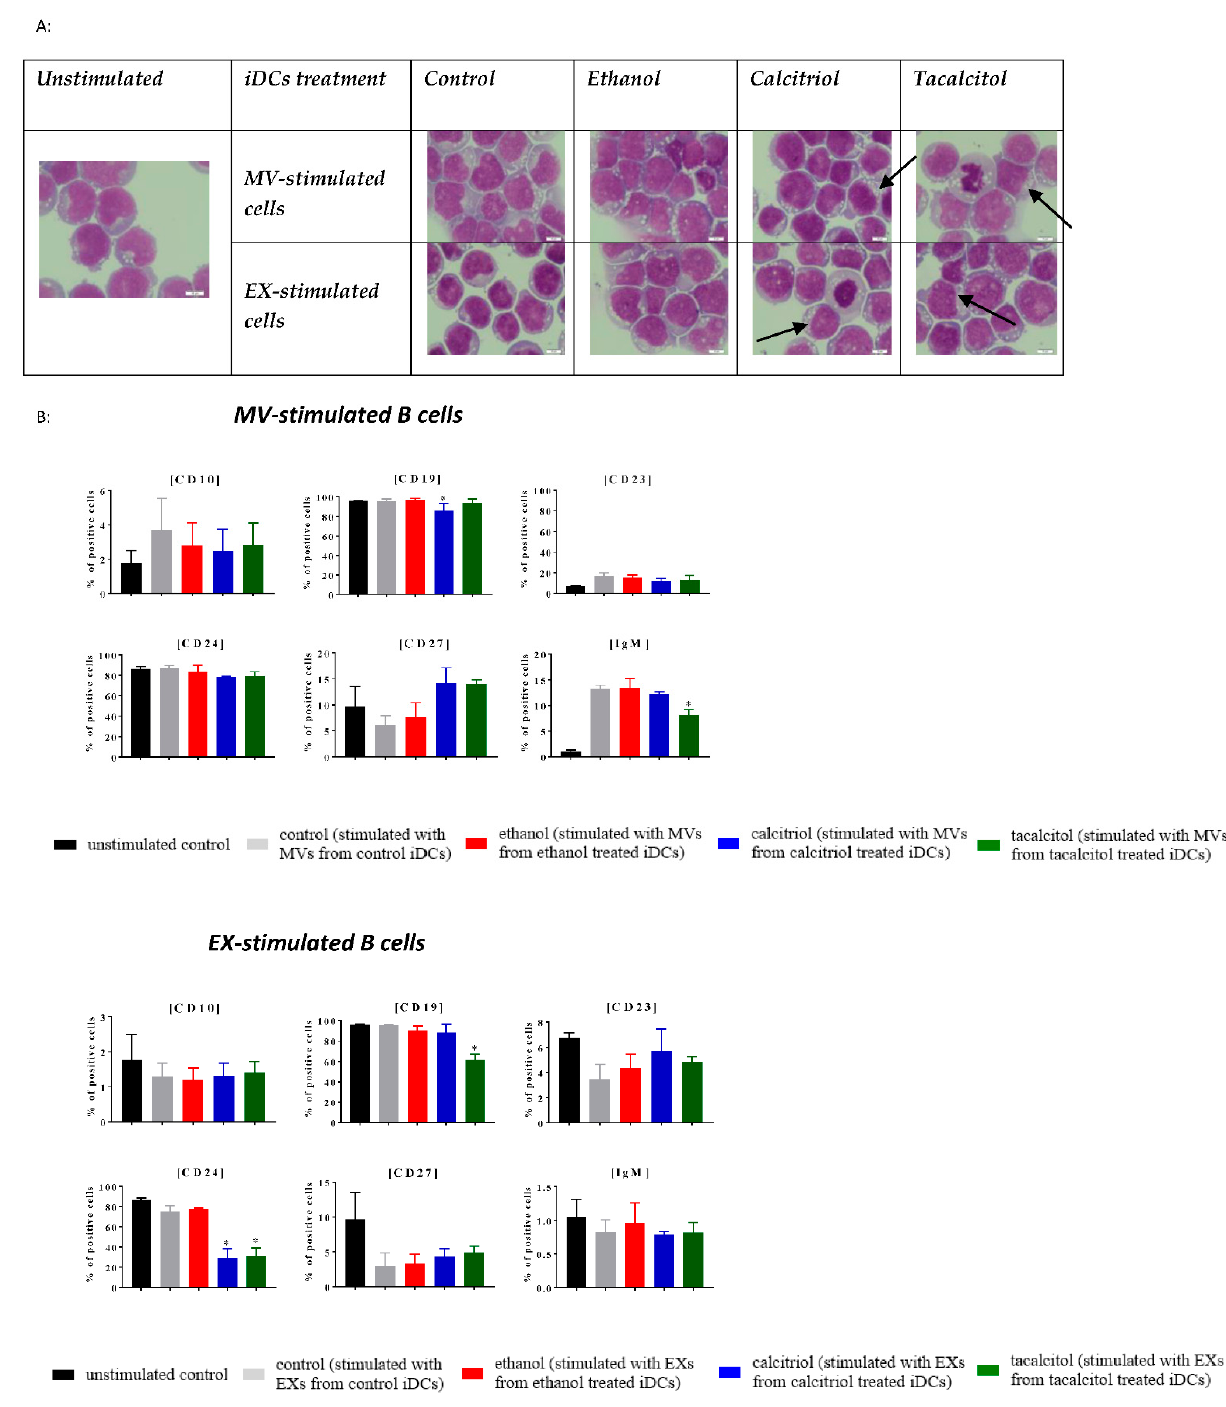
Figure 13. The indirect effects of calcitriol and tacalcitol on RS4;11 cell line after 24 h stimulation with EVs derived from iDCs: ( A ) morphology of EV-stimulated RS4,11 cell line; scale bar 10 μ m. Each staining was performed twice; Black arrows indicate vacuolization in cells. ( B ) distribution of differentiation markers by flow cytometry analysis. Mean values and standard deviation are presented. Statistical analysis: Sidak’s multiple comparison tests in comparison with ethanol were performed; significant differences as compared with ethanol (* p < 0.005). Each experiment was performed at least 3 times.